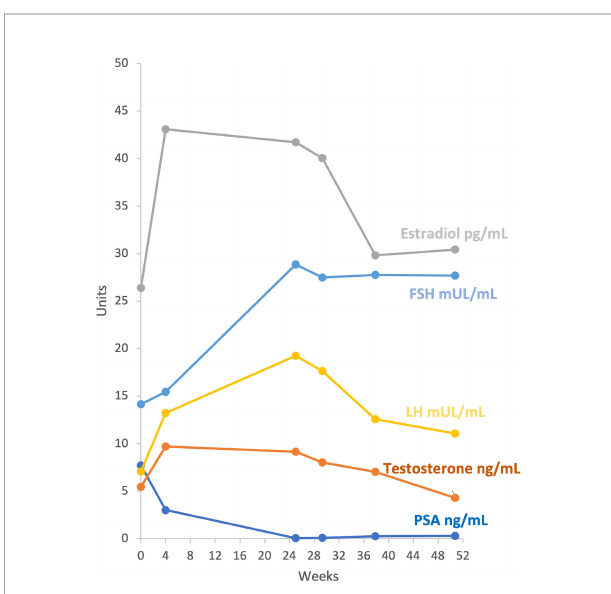
FIGURE 2 | Graphical presentation of PSA and Hormonal pro fi le at pre- speci fi ed timepoints. Data in Y-axis represent number of units (type of units for each parameter is displayed in the fi gure lines). Data in X- axis represent number of weeks after pretreatment